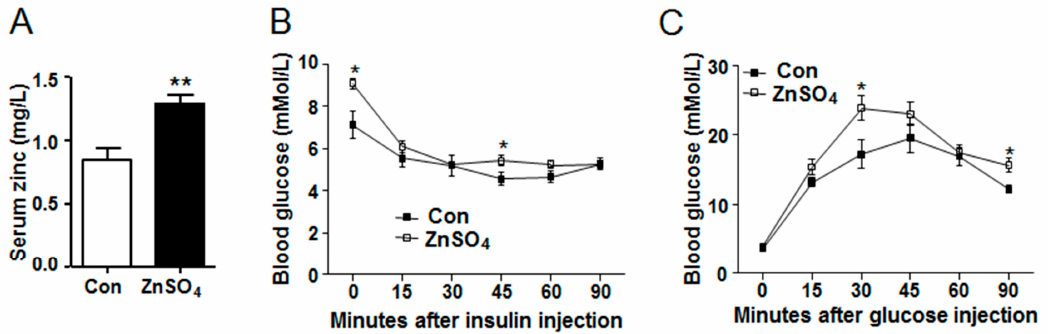
Figure 1. Chronic zinc supplementation impaired systemic insulin sensitivity and glucose clearance.